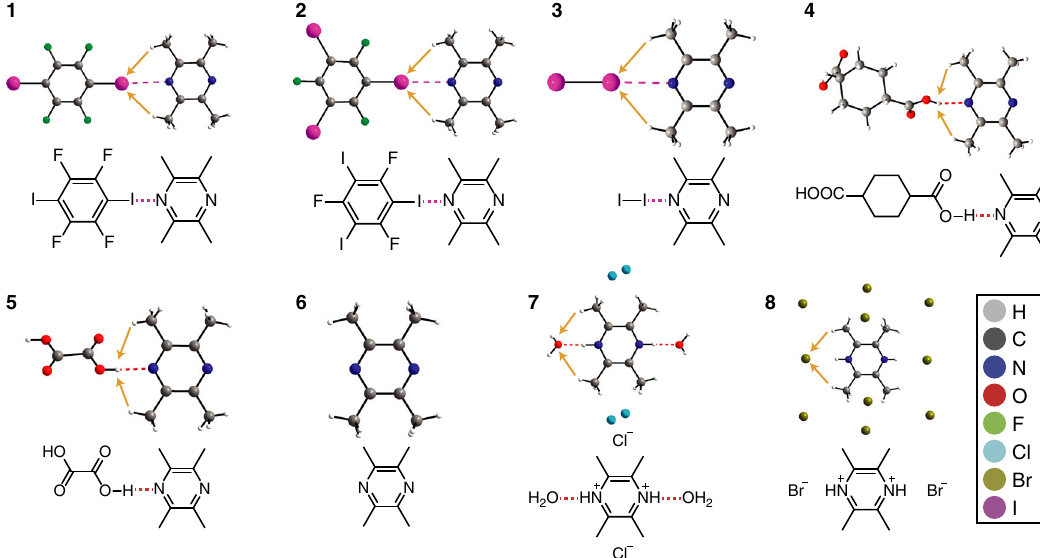
Fig. 1 Depictions of the X-ray crystal structures and molecular structures involving TMP ( 1 – 8 ) surveyed in this work. The dashed magenta lines denote the halogen bonds while the dashed red lines denote hydrogen bonds. The orange arrows denote close contacts between the protons on the methyl group and nearby